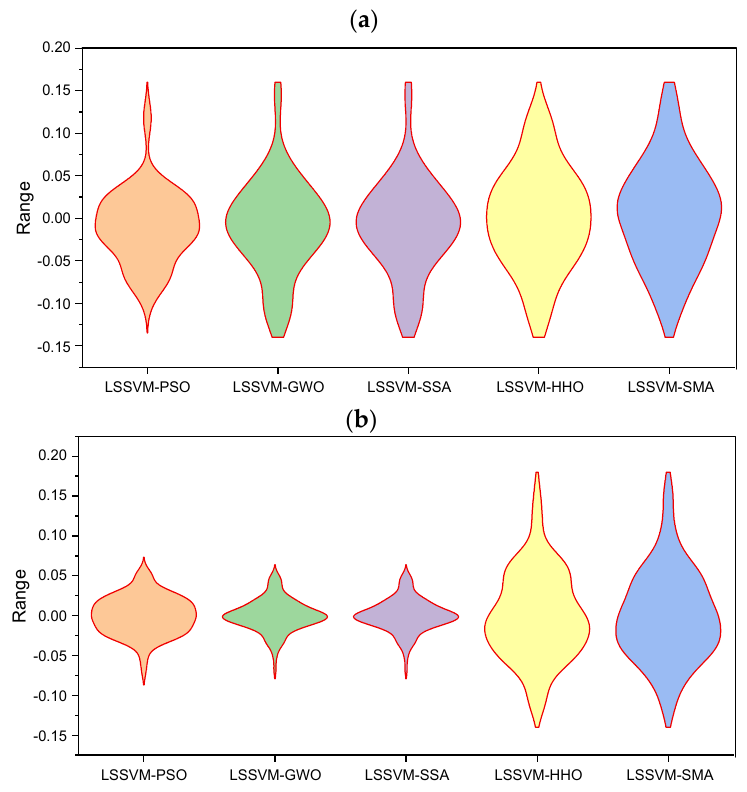
Figure 9. Error plot for the training ( a ) and testing ( b ) datasets.